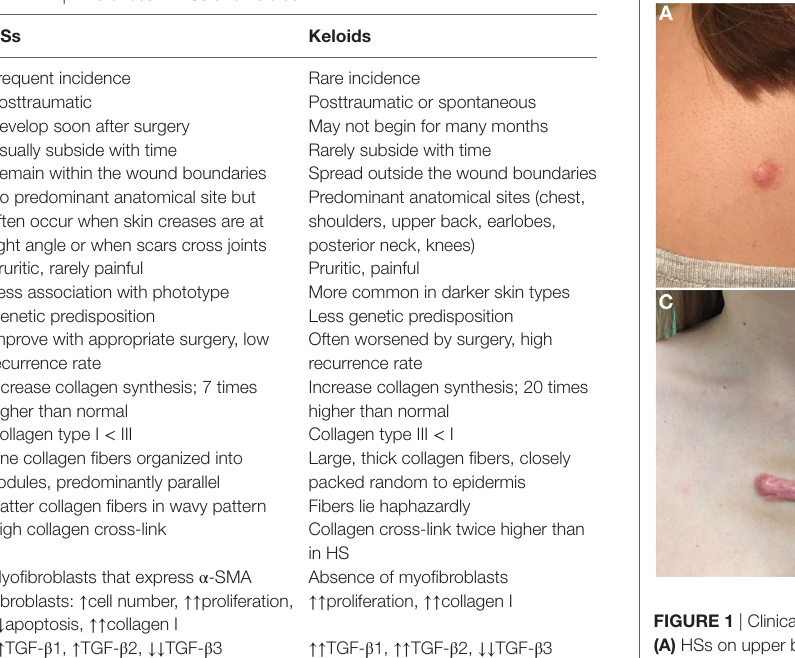
TABLe 1 | Differences in HSs and